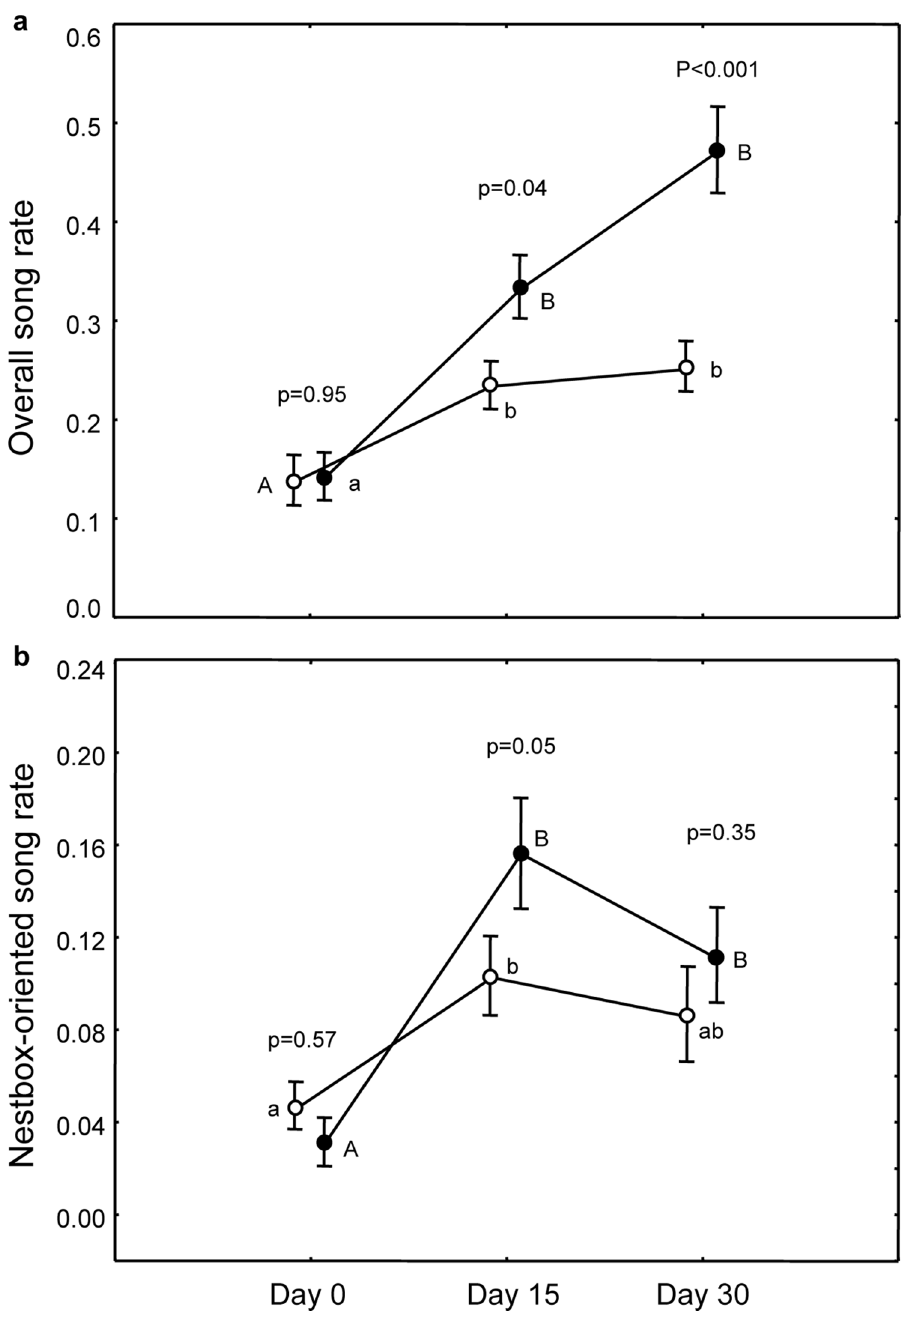
Fig. 1. Effect of dietary carotenoids on song rate. Variation during time of overall song rate (a) and nestbox-oriented song rate in the two groups (full circles for Caro-birds). P values refer to pairwise differences of least square means between groups within the same day (reported only when significant) and within each group between different days (different letters indicate significant difference with song rate observed on day 0; capital for Caro-group and small letters for